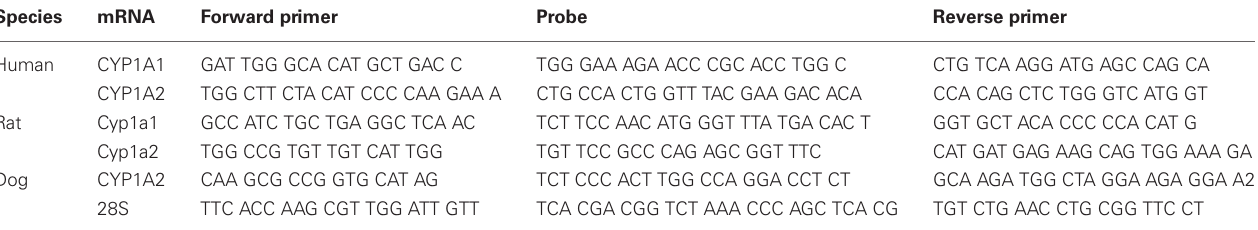
Table A1 | Primer and probe sequences used for RT-PCR assays.